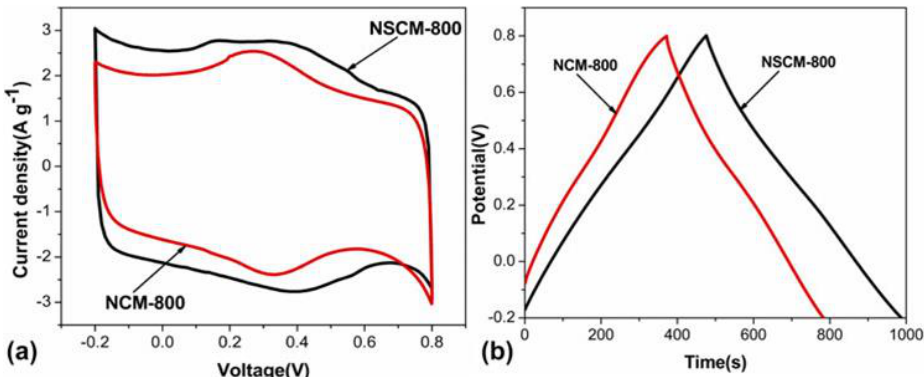
Figure 10. CV curves ( a ) and GCD plot ( b ) of nitrogen and sulfur co-doped benzoxazine at various scan rates (a) or current densities (b). (Reproduced from the work in [56] with permission.)